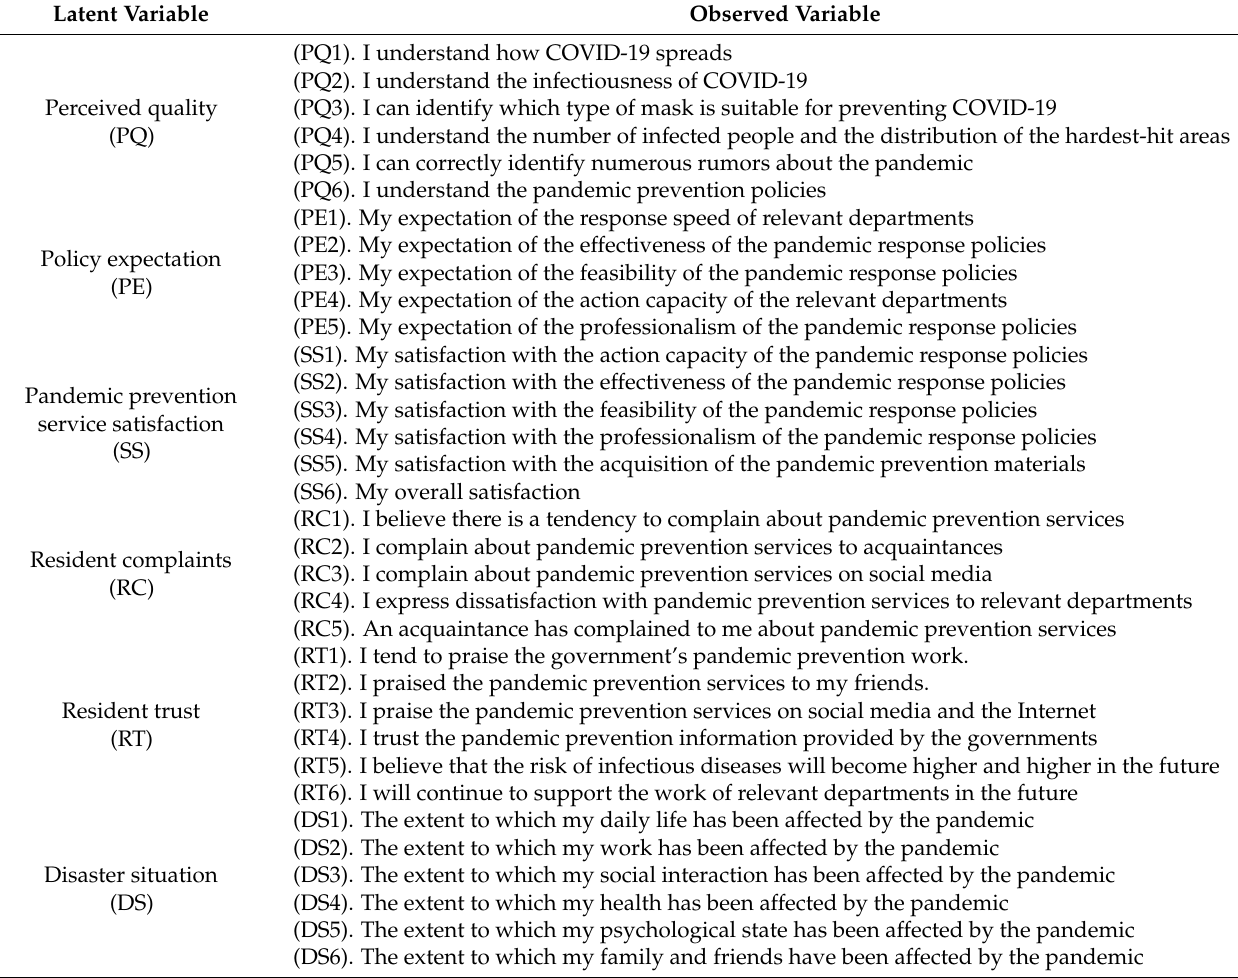
Table 1. The latent and observed